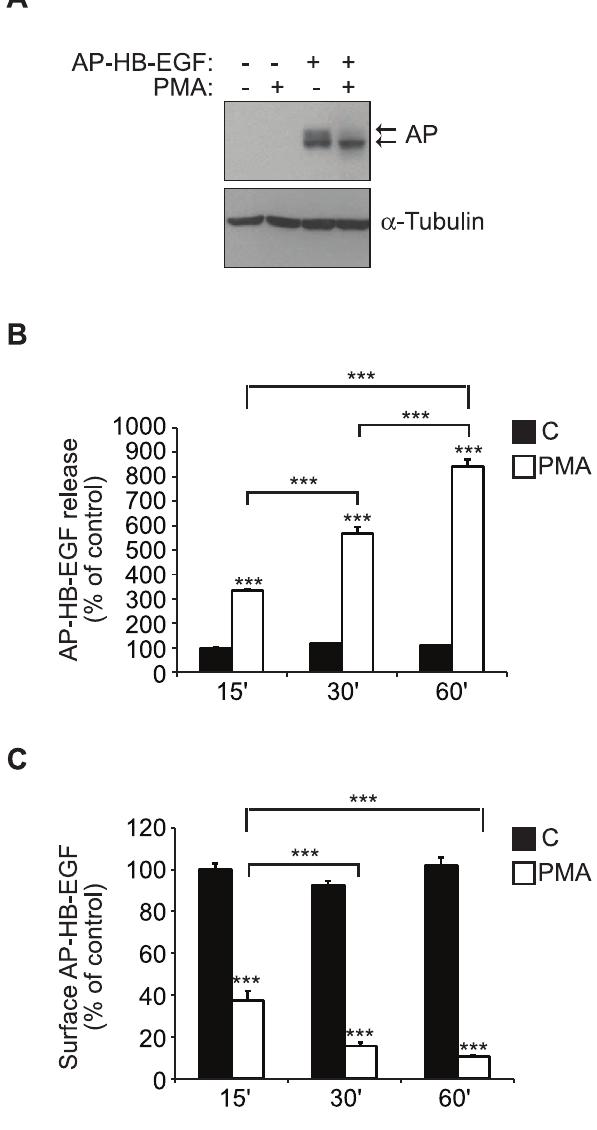
Figure 1. PMA-induced ectodomain shedding of HB-EGF from the cell surface. A ) Western blot analysis of total cell extracts from HT1080 cells stably expressing alkaline phosphatase tagged HB-EGF (AP-HB-EGF) or mock transfected controls after 30 min treatment with 400 nM PMA or DMSO control. a -Tubulin is used as an internal loading control. B ) AP-HB-EGF release measured as alkaline phosphatase activity (absorbance at 405 nm) in conditioned media, and C ) surface AP-HB- EGF measured as cell surface fluorescence intensity per cell (FLU/cell) in AP-HB-EGF expressing HT1080 cells after 15, 30, or 60 min treatment with 400 nM PMA (white bars) or DMSO control (black bars). The graphs show average values 6 standard error of the mean of triplicate experiments. *p , 0.05; **p , 0.01, ***p , 0.001 after one-way ANOVA with Bonferroni’s post tests for multiple comparisons. Unless otherwise indicated, the comparison is relative to the respective control.